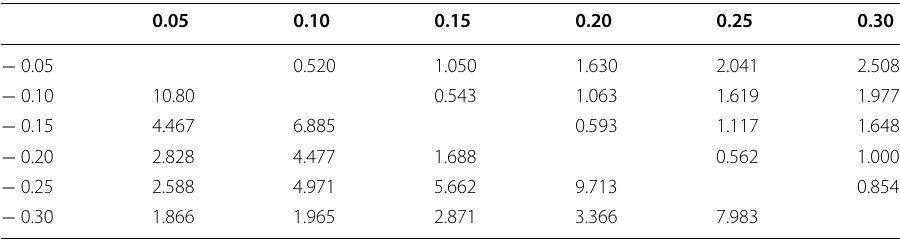
Table 3 Estimated divergence rates of the price trajectories when when φ > φ | − | +